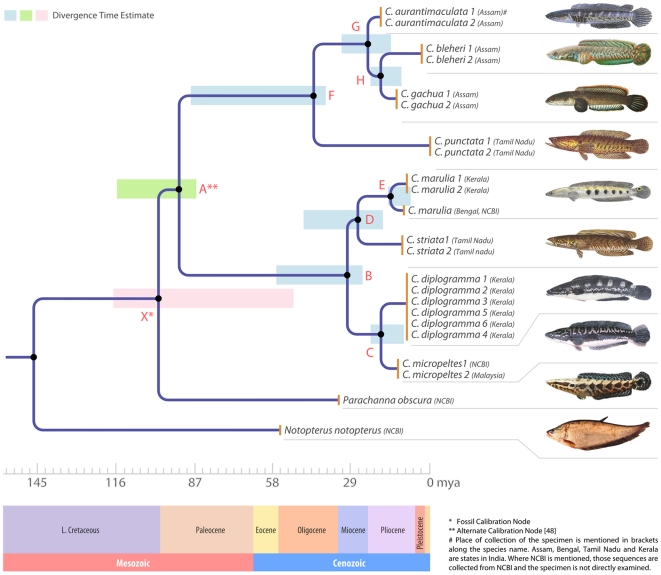
Phylogram showing the relationships of the channids used in this study rooted with Notopterus notopterus (AP008925.1).The nodes for which the divergence time is presented in tables 3 and 4 are labeled as A through H below the branches; the mean time intervals of divergence calculated by the two calibration methods are represented as rectangular bars on the nodes.